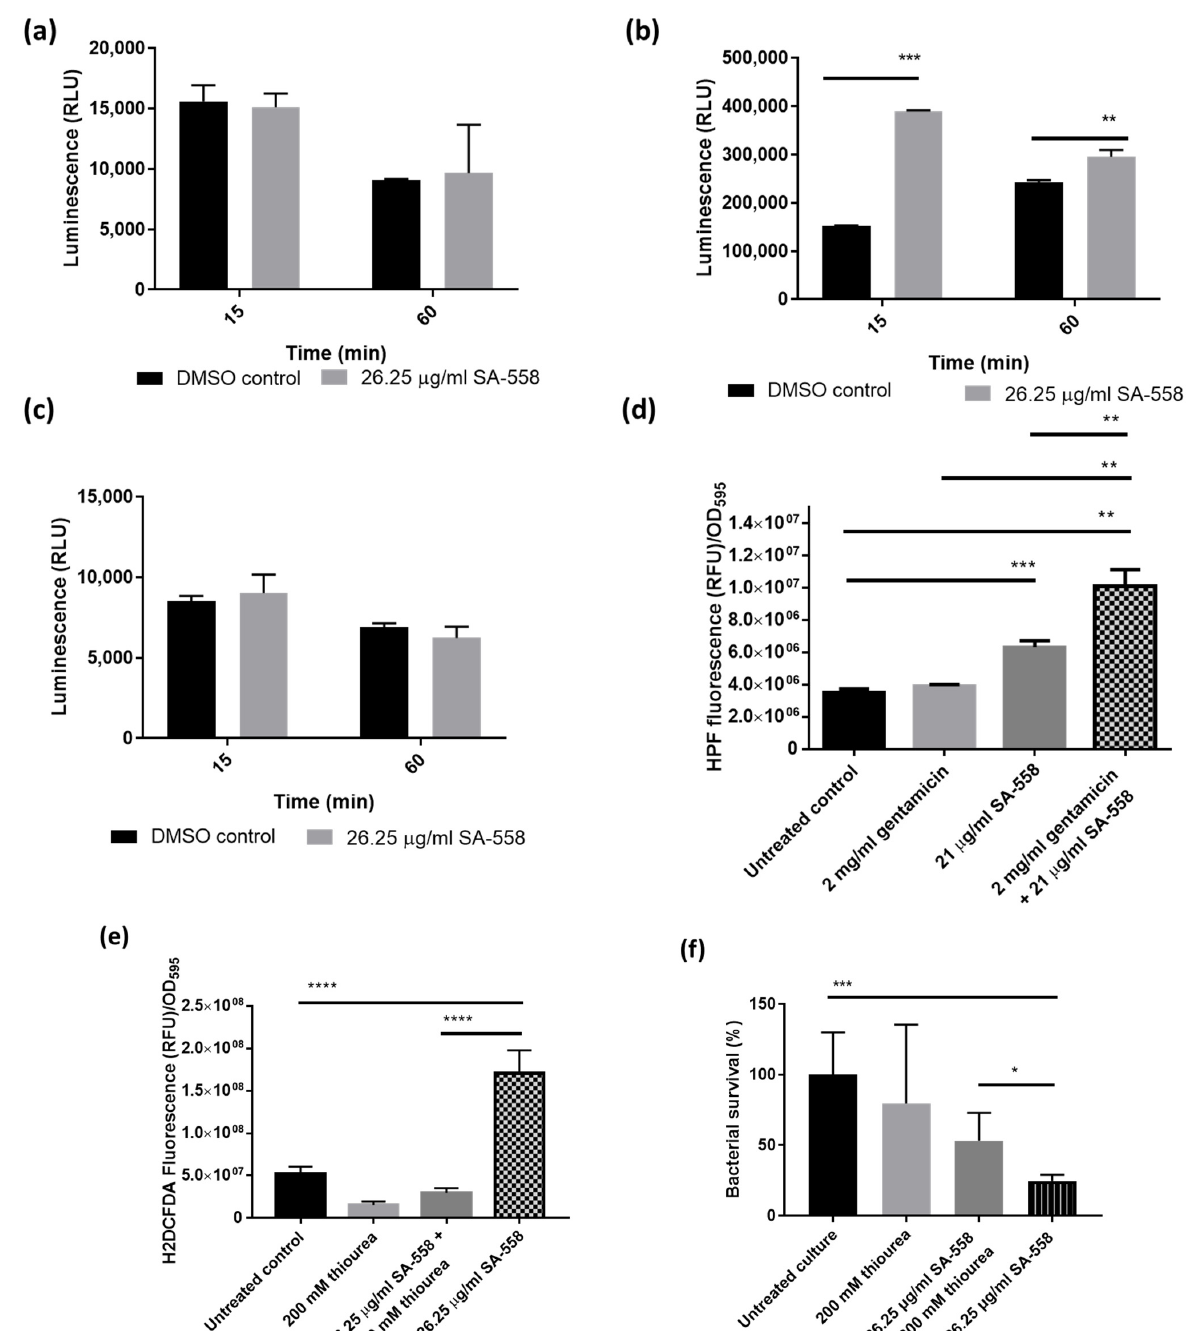
Figure 4. E ff ect of SA-558 on ATP and ROS level of bacterial cells. ( a ) E ff ect of SA-558 on bacterial cellular ATP level in early exponential phase; ( b ) E ff ect of SA-558 on bacterial cellular ATP level in early stationary phase; ( c ) E ff ect of SA-558 on cellular ATP level in Vero cells. Statistical signi fi cance was determined by Student’s t test (** p < 0.01 and *** p < 0.001); ( d ) E ff ect of SA-558 and/or gentamicin on ROS level of S. aureus Mu3, monitored by HPF normalized with OD 595 . ( e ) E ff ect of SA-558 and/or thiourea on ROS level of S. aureus Mu3, monitored by H2DCFDA normalized with OD 595 . ( f ) E ff ect of SA-558 and/or thiourea on bacterial survival of stationary phase S. aureus Mu3. Statistical signi fi cance was determined by one-way ANOVA (* p < 0.05, ** p < 0.01, *** p < 0.001 and **** p ≤ 0.0001). ( a – e ) The data are representative of three independent experiments. ( f ) Pooled means of three independent repeats were presented. Bars represent the mean ± SD.